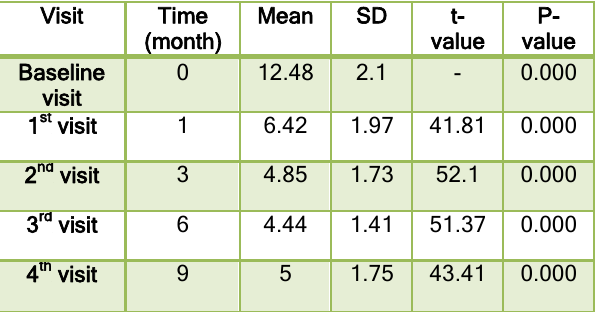
Figure 12.Stiffness scores results with the corresponding visit. Table 4.physical function scores with the corresponding visits.